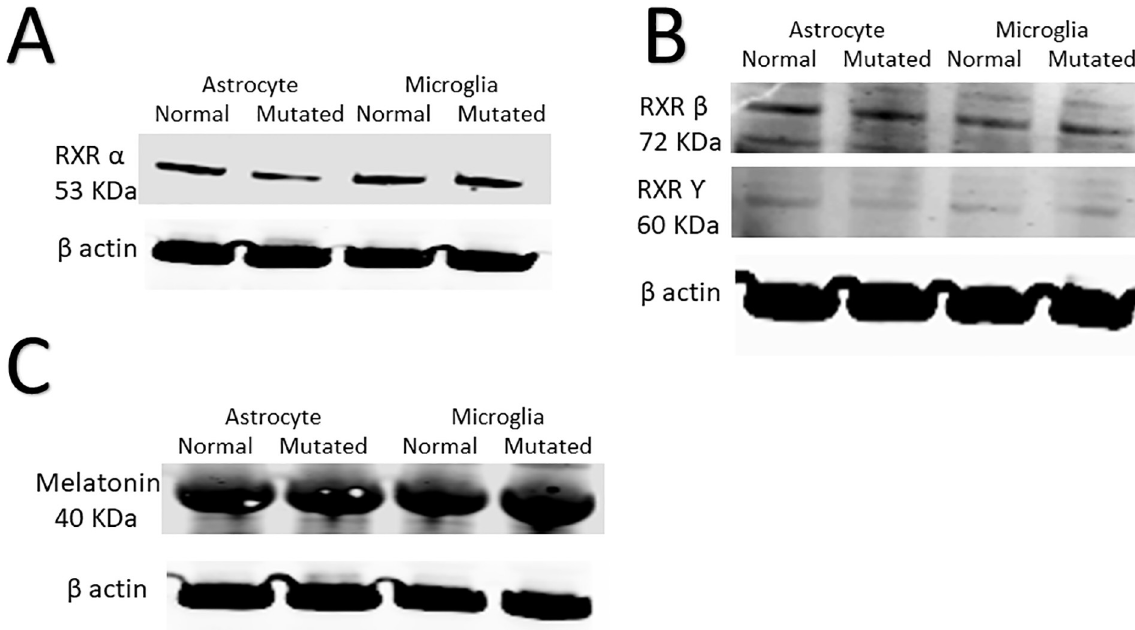
Fig 5. Immunoblots showing the expression of retinoic acid receptors (RXRs) and melatonin. (A) A western blot showing protein expression of RXR alpha ( α ) for mutant microglia and astrocytes compared to normal controls. (B) A western blot showing protein expression of RXR beta ( β ) and gFamma ( γ ) in mutant microglia and astrocytes compared to normal controls. It is worth noting that RXR β and RXR γ were examined in the same blots. Therefore, the loading controls were reused for both entities. (C) A western blot showing the protein expression of melatonin for mutant microglia and astrocytes compared to normal controls; N =